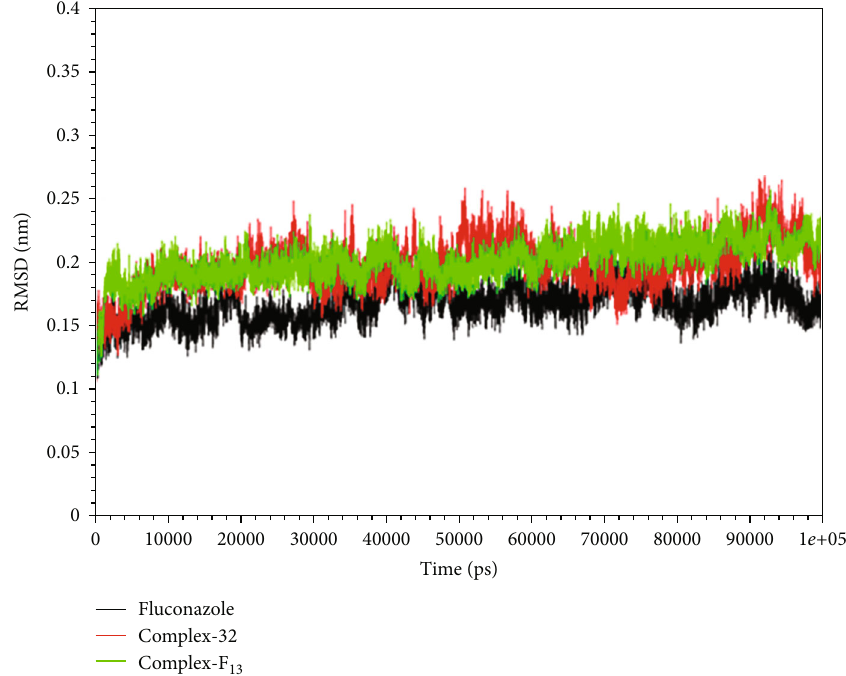
Figure 6: RMSD curve during 100 ns simulation ( fl uconazole: protein- fl uconazole complex, complex-32: protein-ligand complex, complex- F13: protein-ligand